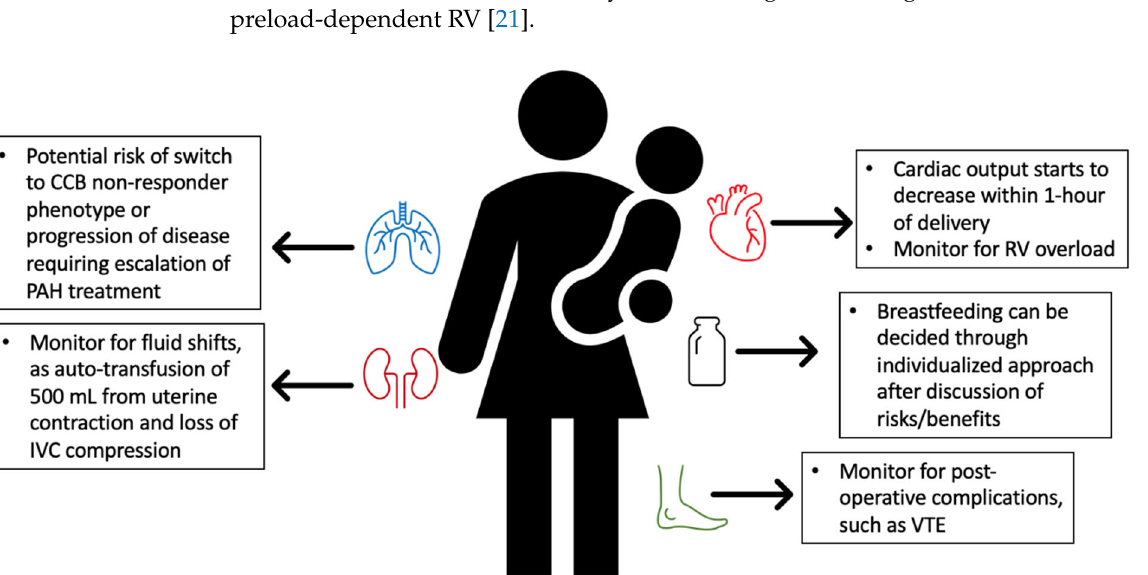
Figure 4. Postpartum changes in the patient with PAH. CCB = calcium channel blocker. PAH = pulmonary arterial hypertension. IVC = inferior vena cava. RV = right ventricle. VTE = venous thromboembolism.